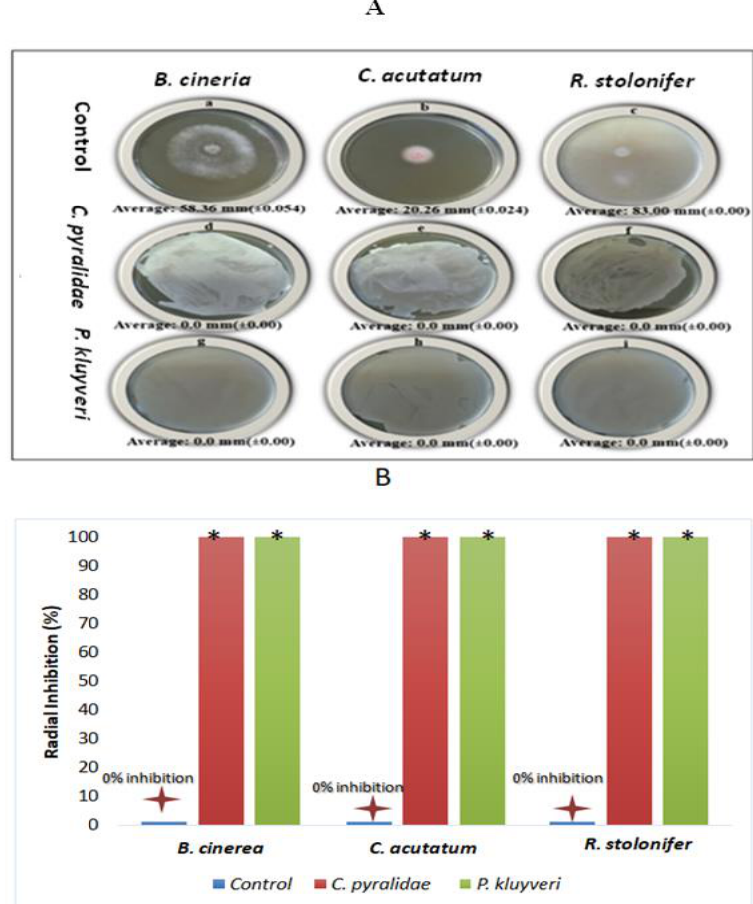
Figure 2. The visual ( A ) and graphical ( B ) representation the antagonistic effect of C. pyralidae cells on B. cinerea (A: d), C. acutatum (A: e) and R. stolonifer (A: f), and the antagonistic effects of Pichia kluyveri cells on the growth of B. cinerea (A: g), C. acutatum (A: h) and R. stolonifer (A: i). The negative controls are displayed as B. cinerea (A; a), C. acutatum (A: b) and R. stolonifera (A: c). Values are averages of three replicates per treatment with the standard deviation given in brackets. The asterisk (*) indicates values that differ significantly from the control ( p < 0.05).